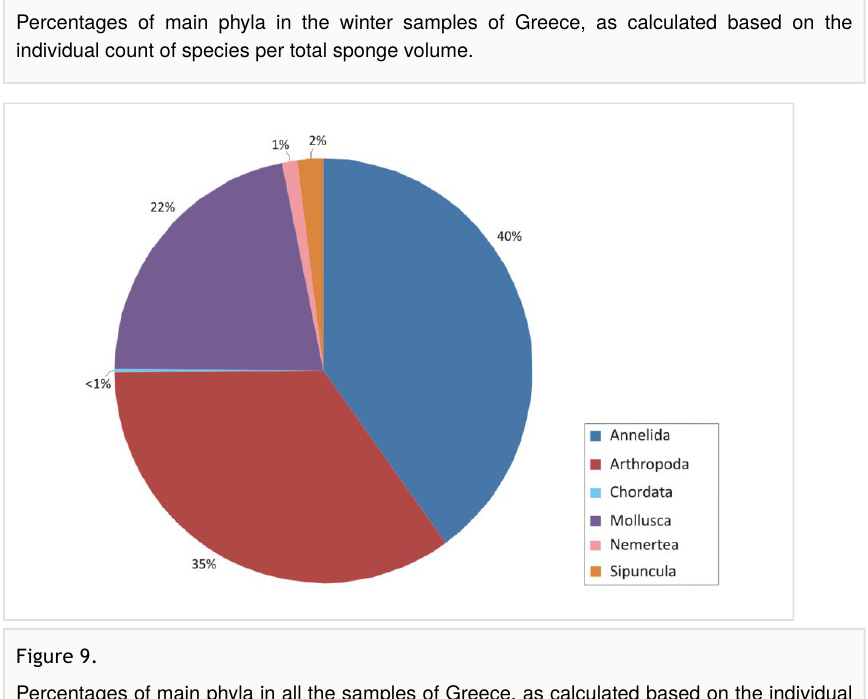
Figure 9. Percentages of main phyla in all the samples of Greece, as calculated based on the individual count of species per total sponge